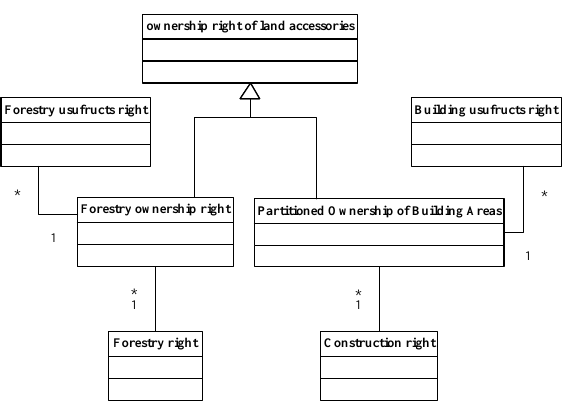
Figure 7. Land accessories ownership and usufructs